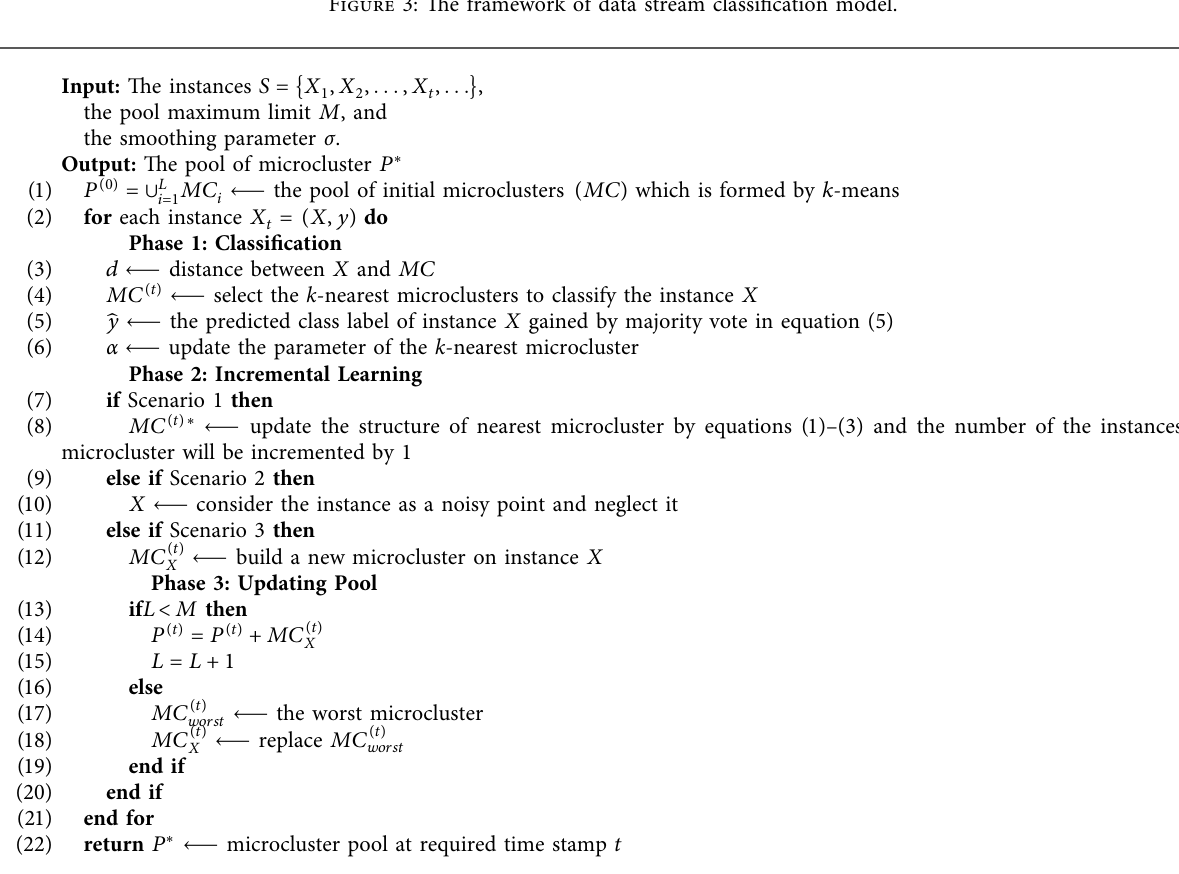
Figure 3: The framework of data stream classification